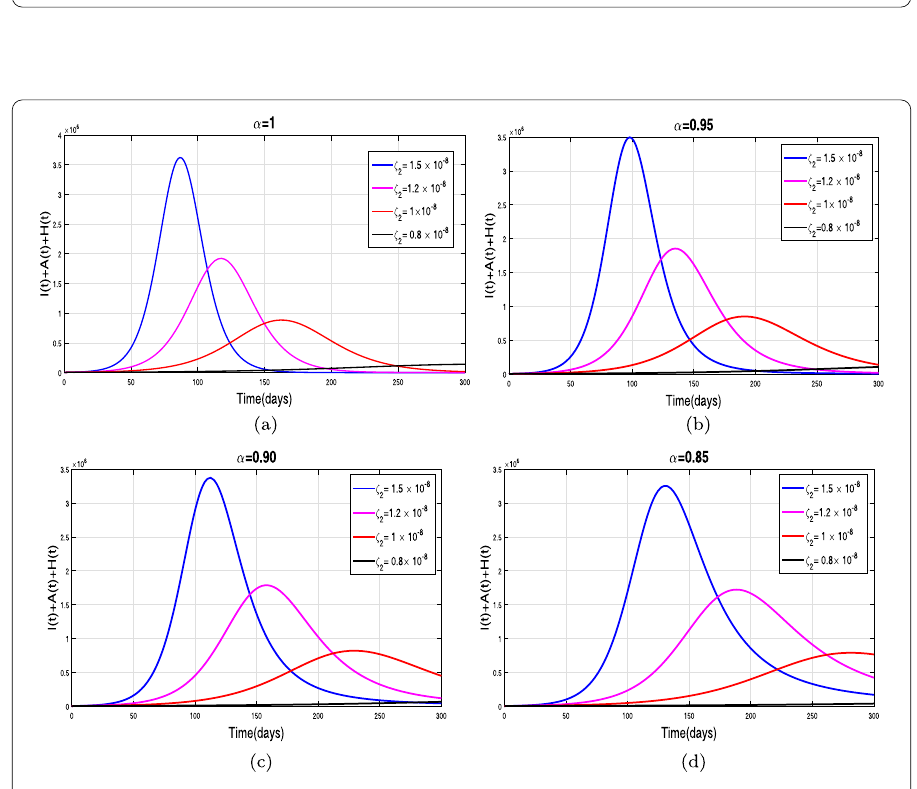
Figure 3 The impact of contact rate ζ 2 on cumulative symptomatic, asymptomatic, and hospitalized COVID-19 individuals for α = 1, α = 0.95, α = 0.90, α =